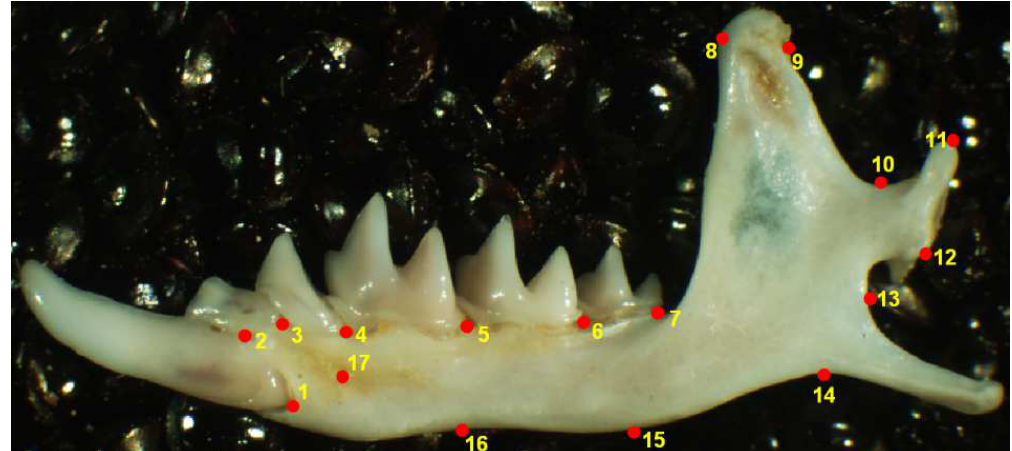
FIGURE 2. Landmarks positioned on the labial side of the left